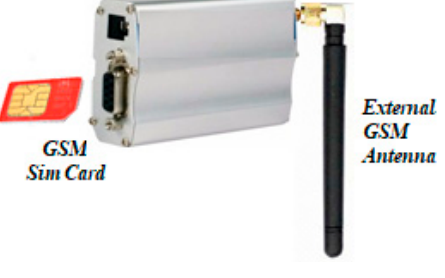
Figure 3. GSM modem.